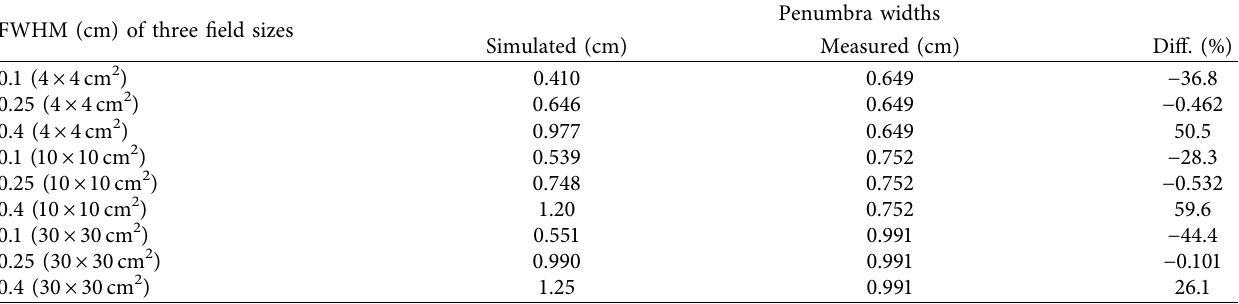
Table 2: The comparison of simulated and measured penumbra widths (cm) at 0.1, 0.25, and 0.4cm for three different fields at 10 cm depth. The uncertainties of simulated values were less than or equal to 2% under the condition of k � 2. FWHM (cm) of three field